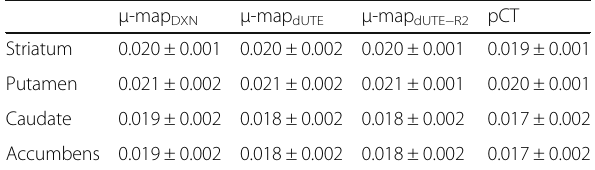
Table 4 Mean K i op and standard deviation (cm − 1 )